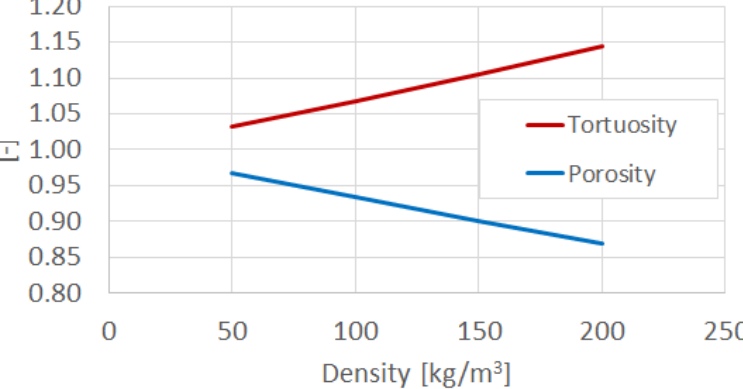
Figure 4. Schematic diagrams of the porosity measurement system based on the air volume com- pression method: ( a ) before the compression, ( b ) after the compression of know volume Δ V [26].